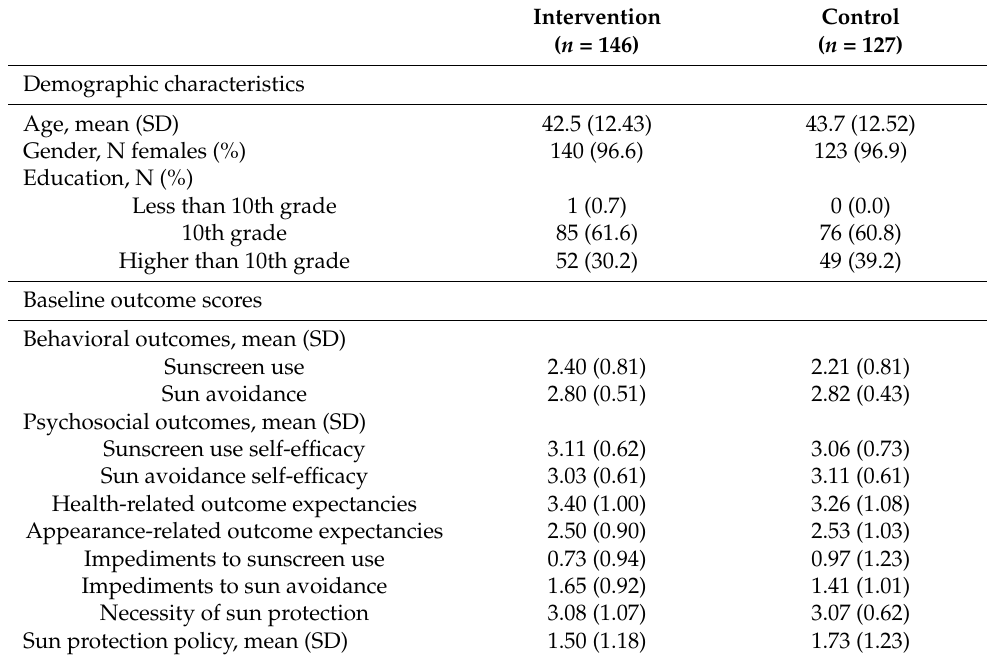
Table 4. Baseline demographic characteristics and baseline outcome scores of preschool